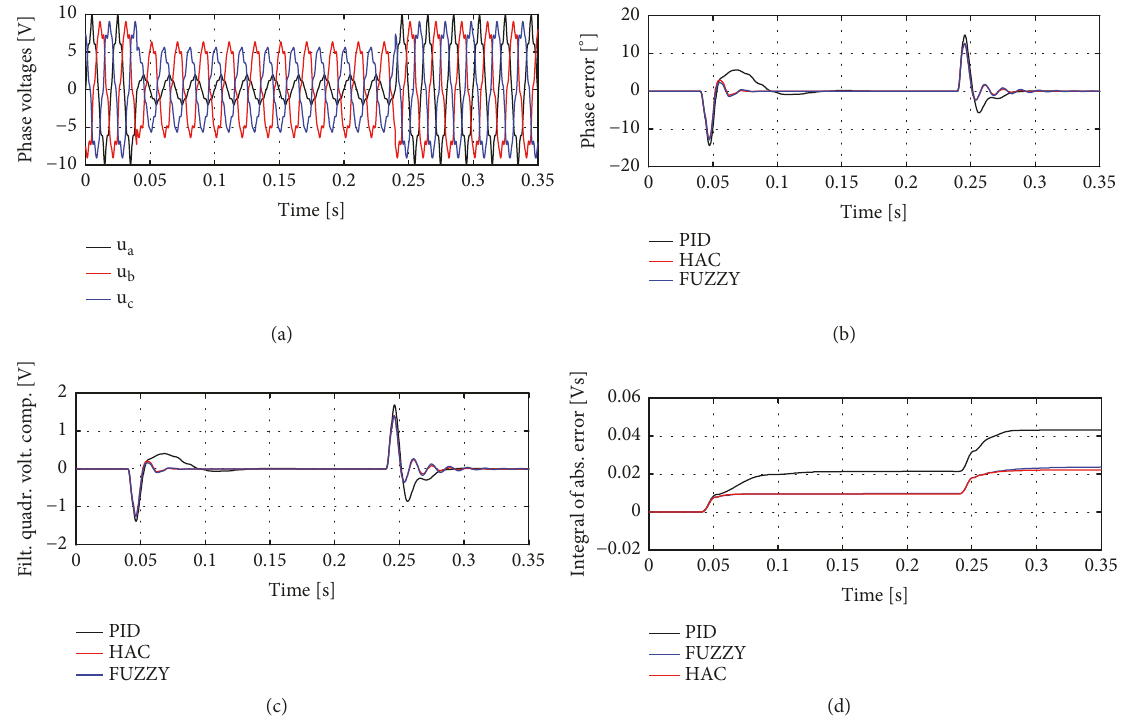
Figure 11: Phase voltages (a), phase error (b), filtered quadrature voltage component 𝑢 𝑞 (c), and integral of absolute error (d) for the unbalanced voltage sag in phases a and c with harmonics